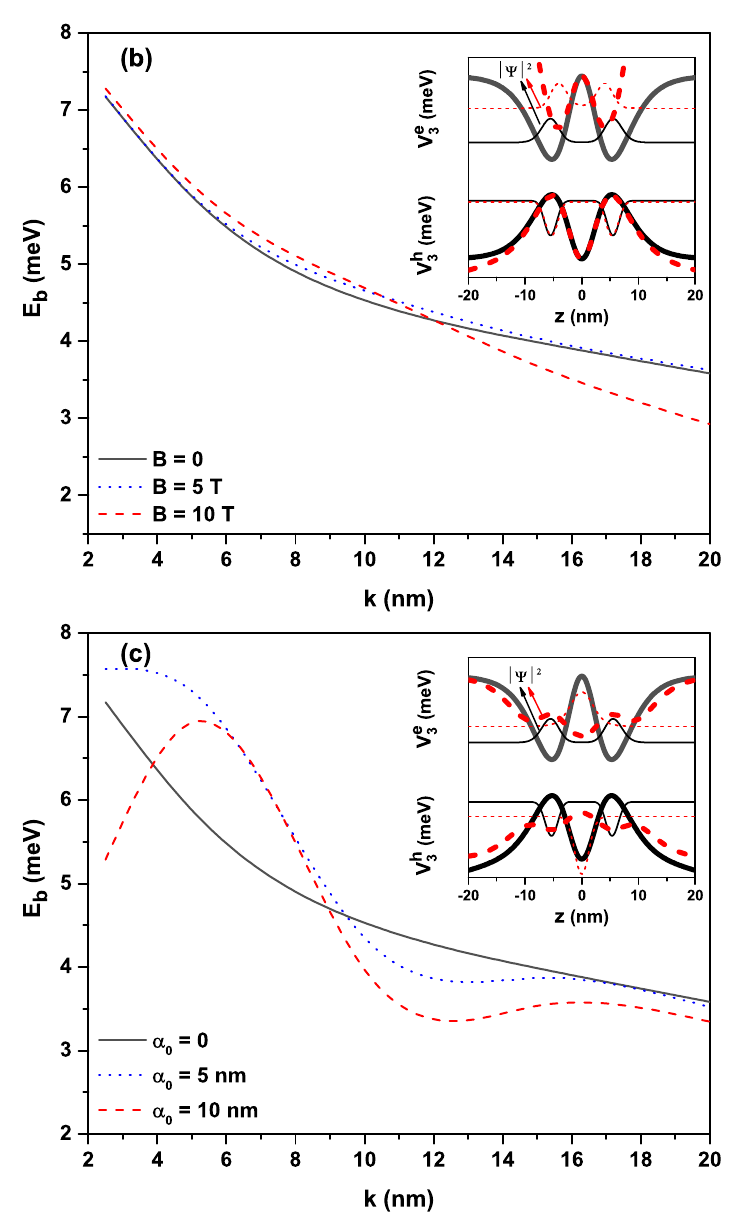
Figure 3. Heavy-hole exciton binding energy as a function of the well width parameter for con- ( h ) ν 3 sinh 2 ( z / k ) sech 4 ( z / k ) in the presence of the external fields: finement potential V 3 ( z e ( h ) ) = − V e 0 ( a ) electric field ( B = 0 and α 0 = 0), ( b ) magnetic field ( F = 0 and α 0 = 0), and ( c ) intense laser field ( F = 0 and B = 0), respectively. The inset in each figure shows the changes in the confinement potentials (thick lines) and the square of the ground state wavefunction (thin lines) for the electron and hole, considering the lowest and highest values of the corresponding field in each panel. Results are for ν 3 =